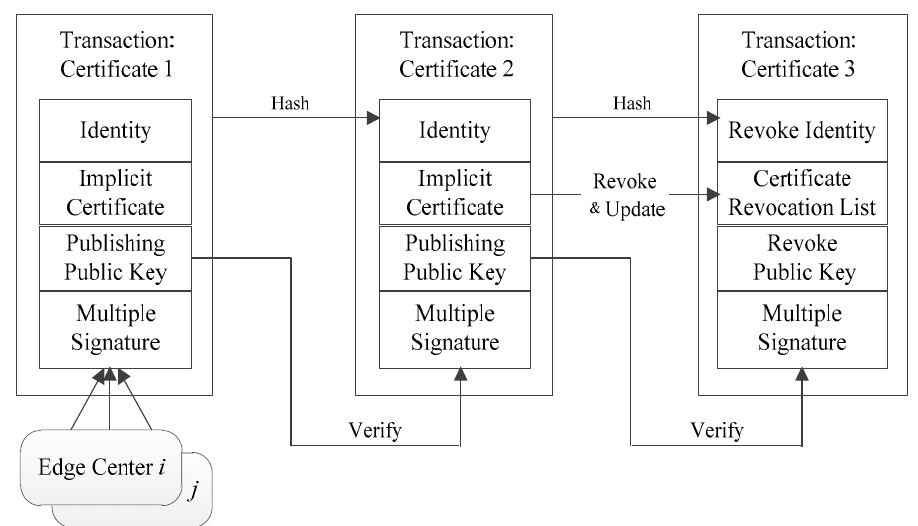
Figure 5. Identity and certificate management based on blockchain.